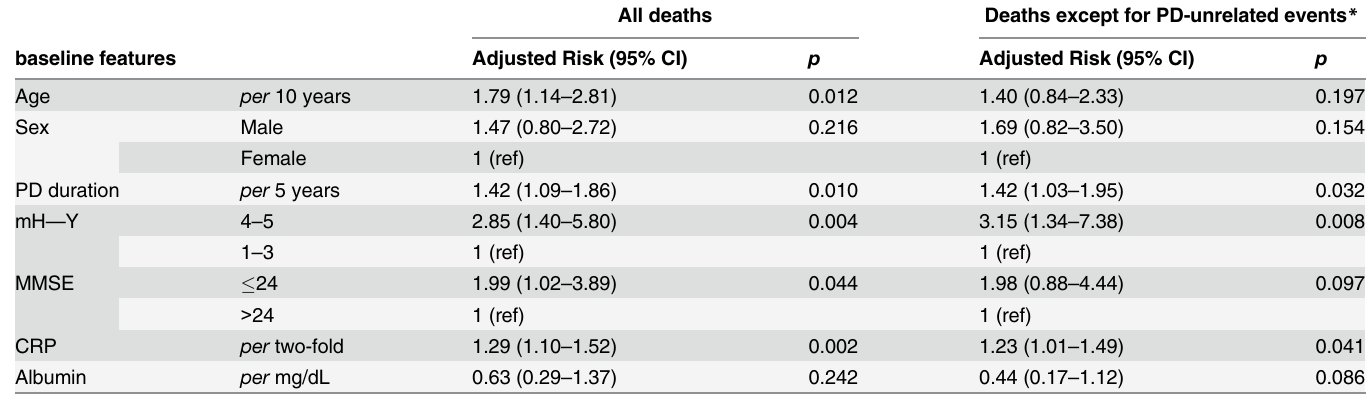
Table 1. Relative risk of death by clinical features in Parkinson disease. All deaths Deaths except for PD-unrelated events